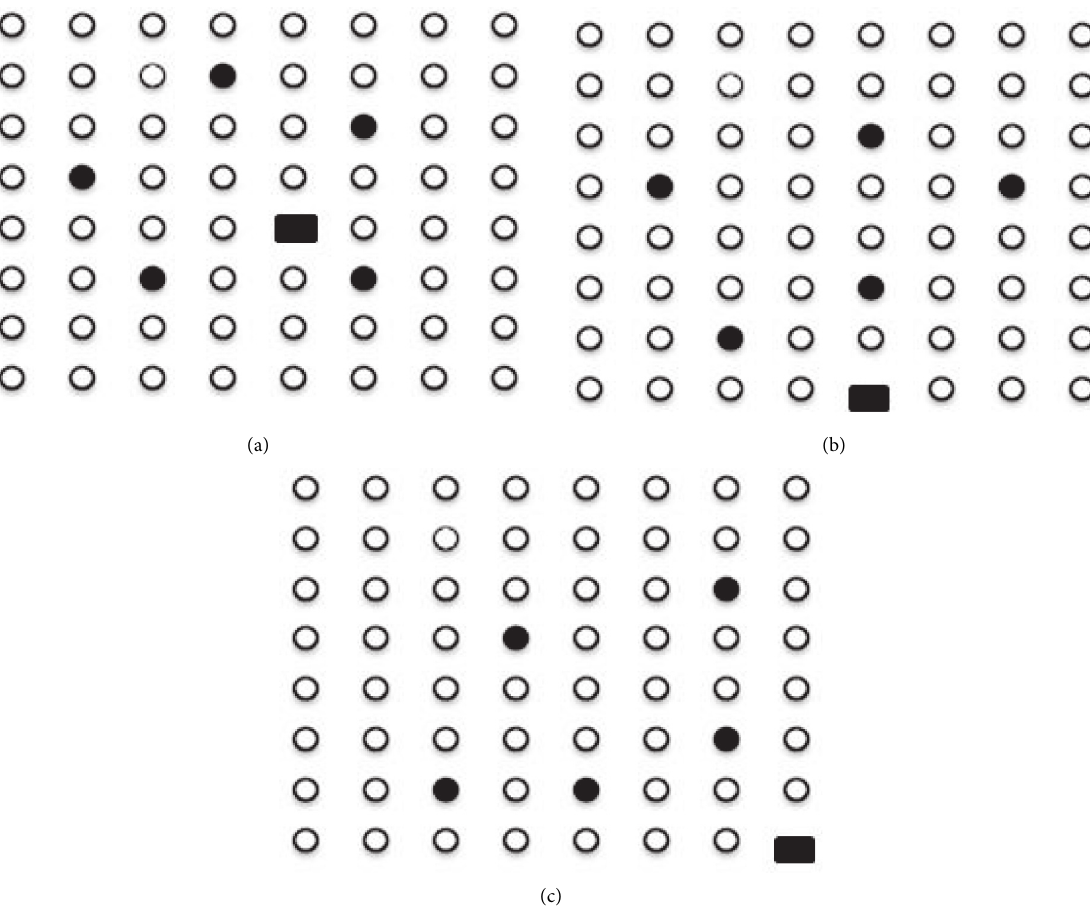
Figure 3: The optimum placement of wireless hubs and the gateway for (a) configuration Type 1, (b) configuration Type 2, and (c) configuration Type